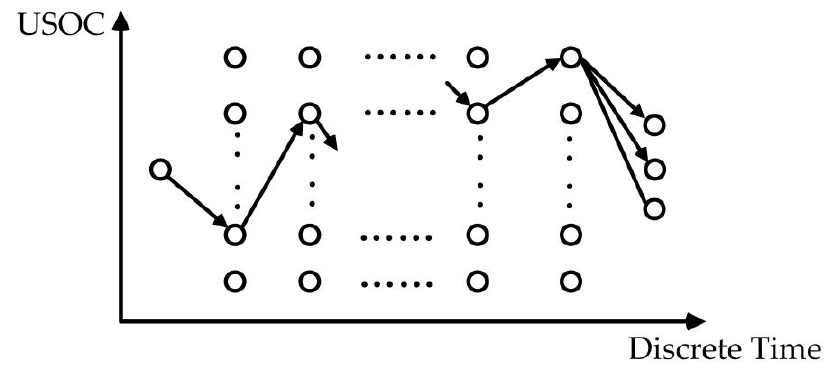
Figure 9. DP process.